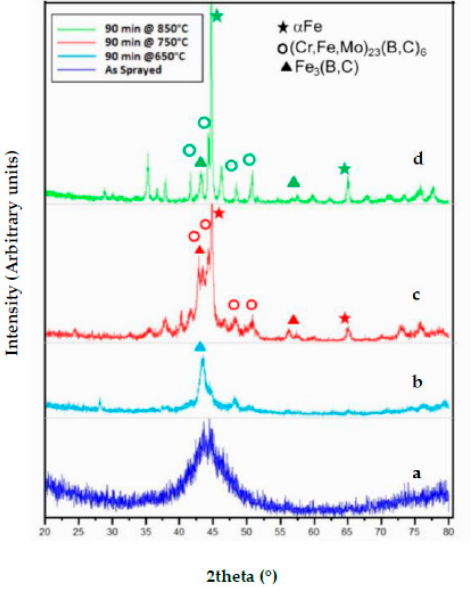
Figure 7. XRD patterns of CGS coatings: as-sprayed (a); heat-treated for 90 min at 650 °C (b); 750 °C (c); 850 °C (d).